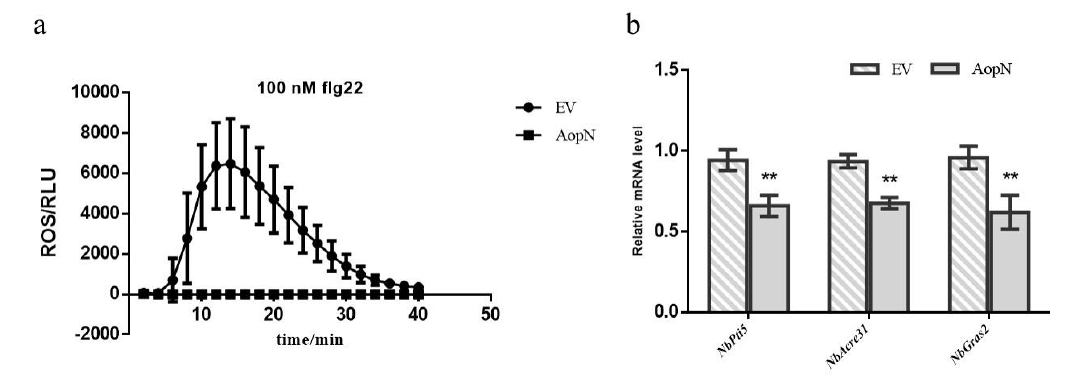
Figure 6. AopN inhibited pathogen-associated molecular pattern-triggered immunity (PTI) responses. ( a ) AopN inhibited pathogen-associated molecular pattern (PAMP) flg22-induced reactive oxygen species (ROS) burst in N. benthamiana. Agrobacterium tumefaciens strain GV3101 carrying AopN-FLAG reduced ROS production induced by flg22 in N. benthamiana compared with that carrying the EV (empty vector) controls. The experiment was performed three times, with similar results obtained each time. Data represent the means ± SD ( n = 10). (b) Expression levels of the PTI markers: NbPti5 , NbAcre31 , and NbGras2 with flg22 treatment. The experiment was performed three times, with similar results obtained each time. Data represent the means ± SD ( n = 3). ** above bars indicate significant differences as determined by t-test, p < 0.05